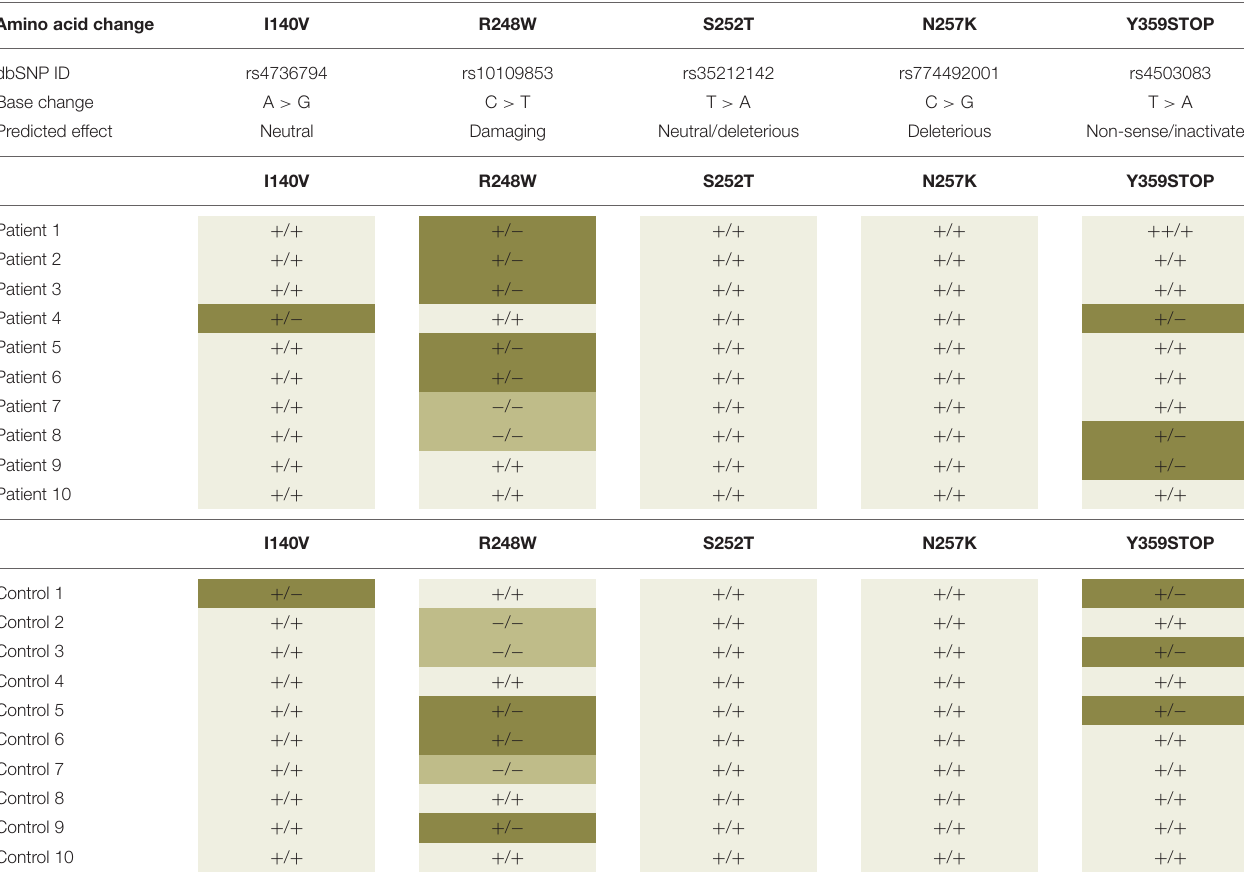
TABLE 1 | Examination of the IDO2 gene for mutations in ME/CFS patient and age gender matched healthy controls. Amino acid